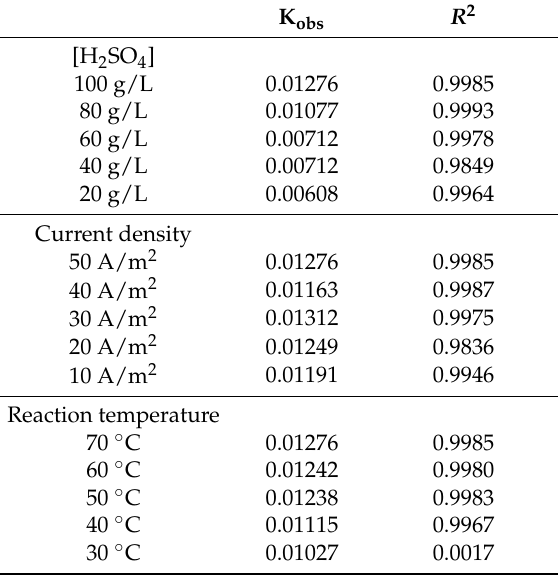
Table 1. Constants and correlation coefficients of pseudo-first order for reduction of chromium